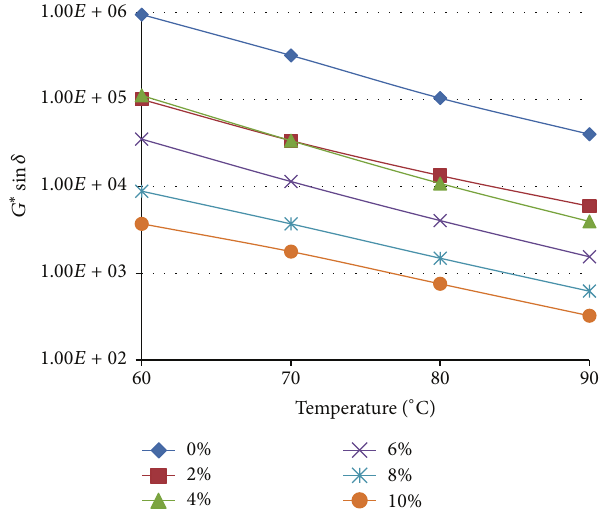
Figure 7: The variation of the fatigue cracking resistance parameter ( 𝐺 ∗ sin 𝛿 ) of WCO modified TLA with increasing temperature at a frequency of 1.59 Hz.